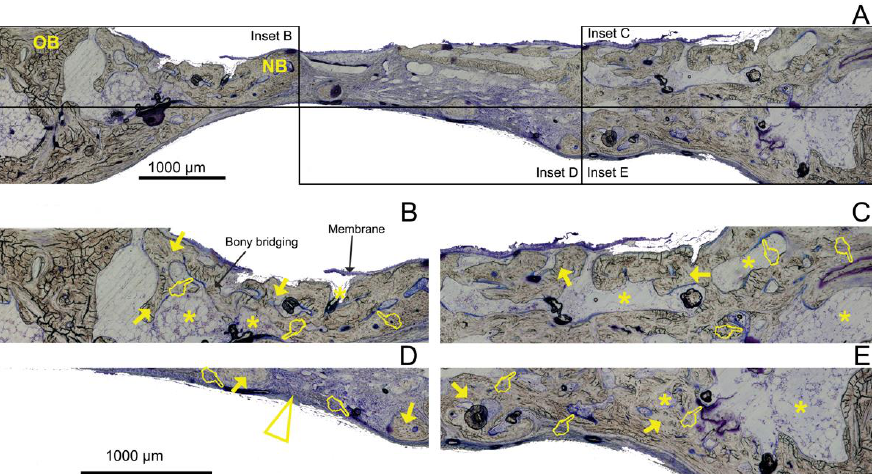
Figure 4. Bone histology obtained after using Zn-HOOC-Si-loaded membranes dyed with toluidine blue to visualize mineralized bone at 6 weeks of healing time. Single arrows point to the presence of new bone area (NBA). Osteoid area (OA) is signaled by pointers, and soft tissue area (STA) is indicated by asterisks. Arrowhead indicates osteons. ( A ) General view. OB — old bone; NB — new bone. Insets AB, AC, AD, and AE reflect the corresponding areas analyzed in Figure 4B – E; ( B ) indicates a partial view of R1 area (top left); ( C ) R3 (top right); ( D ) R5 (bottom central); and ( E ) R6 (bottom right). ( B ) shows the zone with the highest NBA value observed; a bony bridging formed, and membrane is displayed (R1). ( D ) characterizes one of the lowest NBAs analyzed (R5, central adjacent to the dura mater). ( A , C , E ) permit the observation that osteoid bone primarily occupied the lateral areas of the defect. Soft tissue was present in a lower proportion when compared with the rest of the groups after using this zinc-doped membrane.